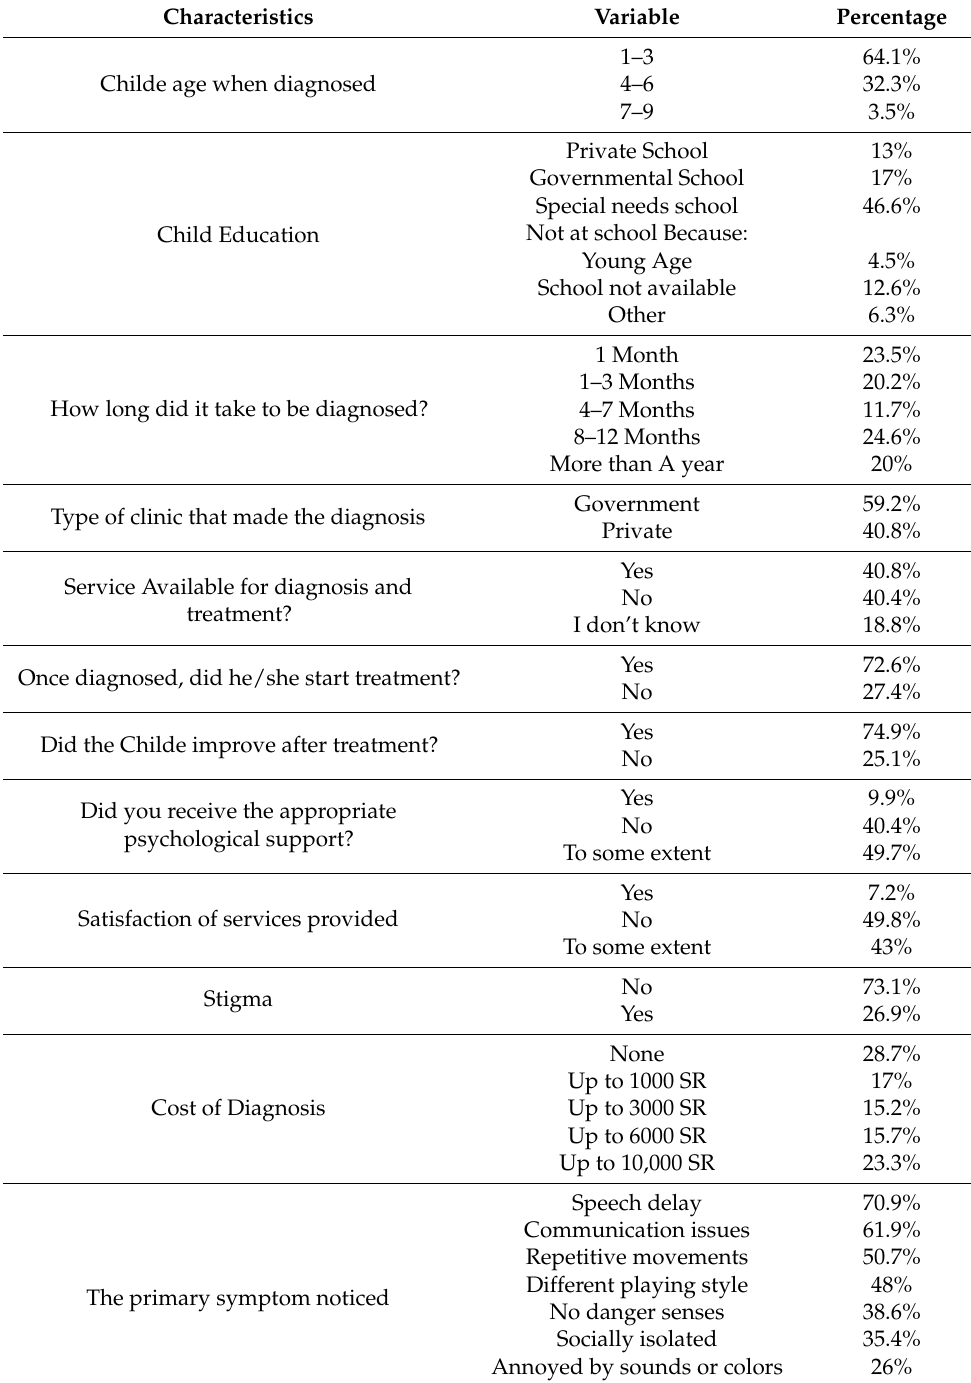
Table 3. Diagnosis and